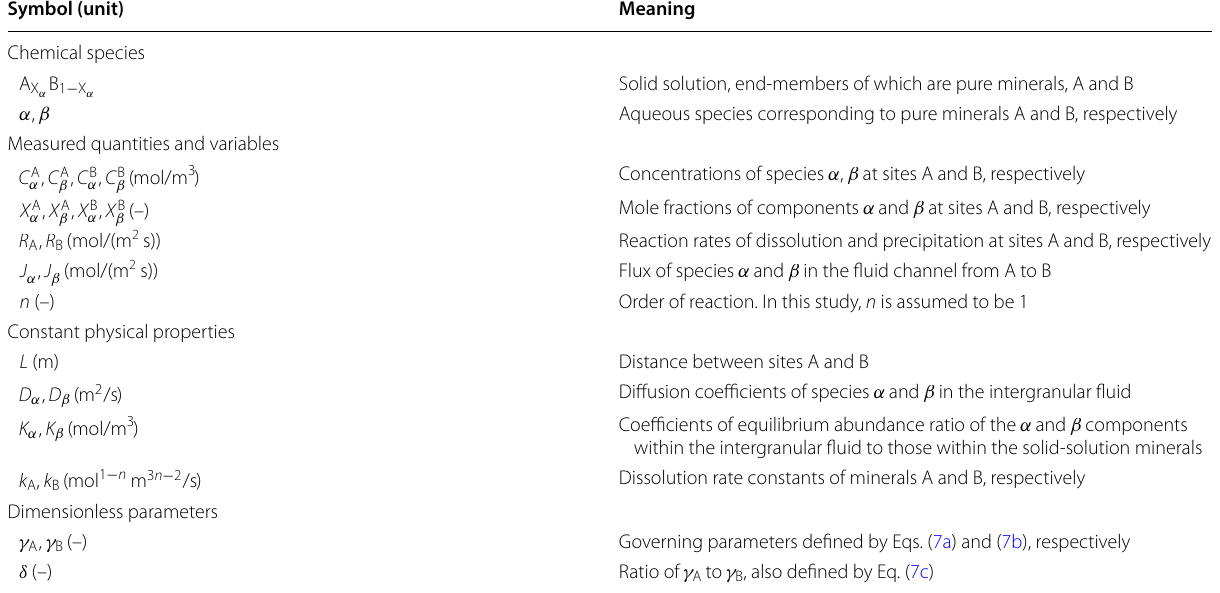
(–) indicates a dimensionless number